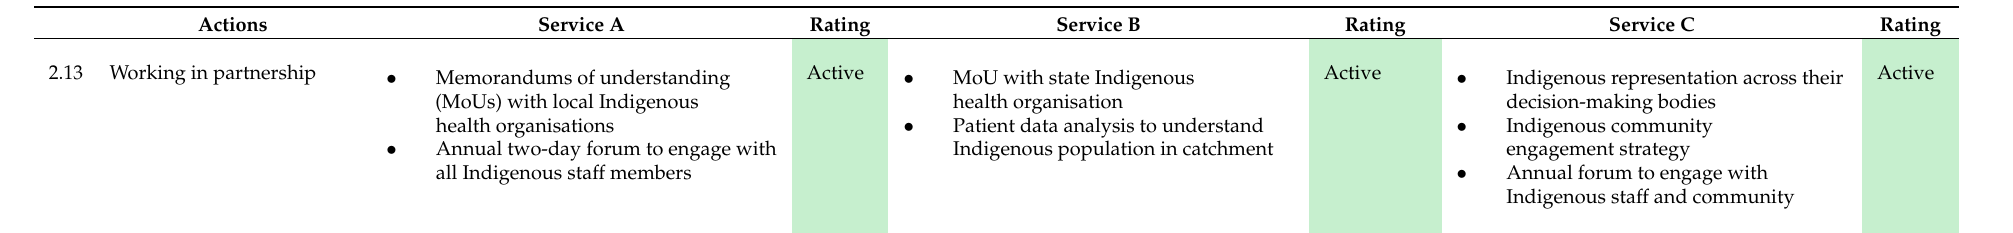
Table 2. Cancer service performance scored against the NSQHSS User Guide for Aboriginal and Torres Strait Islander Health actions using traffic light rating system.